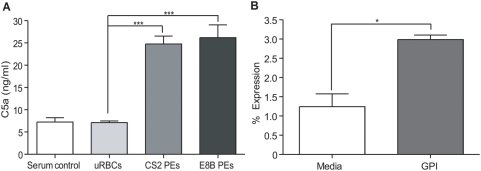
Parasitized erythrocytes (PEs) induce C5 activation and pfGPI upregulates C5aR expression on monocytes.(A) Serum from malaria-naïve donors was added to mature stage CS2 (CSA binding) PEs or E8B (ICAM-1 and CD36 binding), uninfected red blood cells (uRBCs) or media for 30 min and supernatants were assayed for C5a by ELISA. Increased C5a levels were observed in the supernatants of PEs compared to uRBC or control, (Student's t-test: uRBCs vs. Mature PEs ***p<0.001). Data are presented as means±SEM and are representative of four independent experiments for CS2 parasites and two independent experiments for CD36-binding parasites. (B) Human PBMCs were stimulated with pfGPI or unconjugated gold beads alone as a control for 24 h. Expression of C5a receptor was determined by flow cytometry on monocytes (CD14). The percentage of monocytes expressing C5aR was significantly higher for pfGPI-treated versus media control cells, (Student's t-test: *p = 0.0279). Data are presented as means±SEM and are representative of two independent experiments.